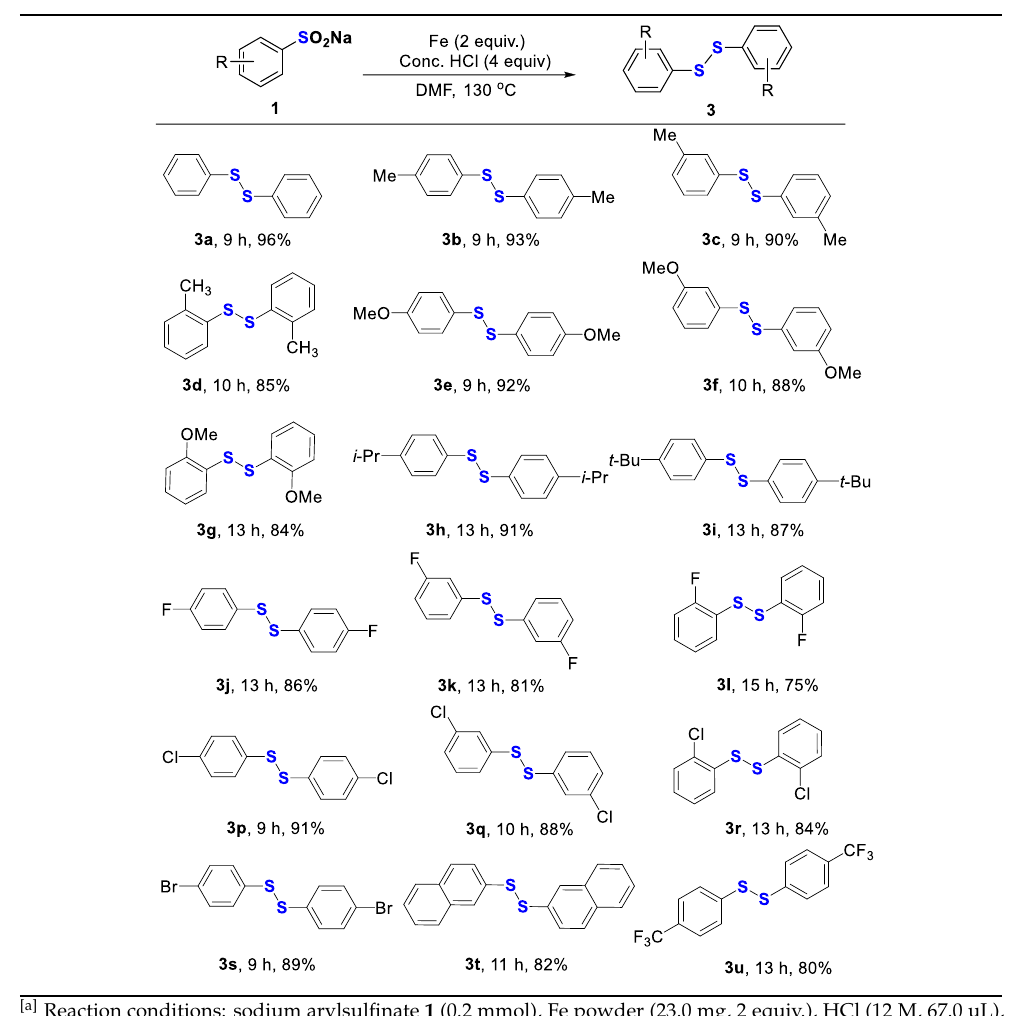
Table 4. Scope of sodium arylsulfinates to diaryl disulfides [a,b]